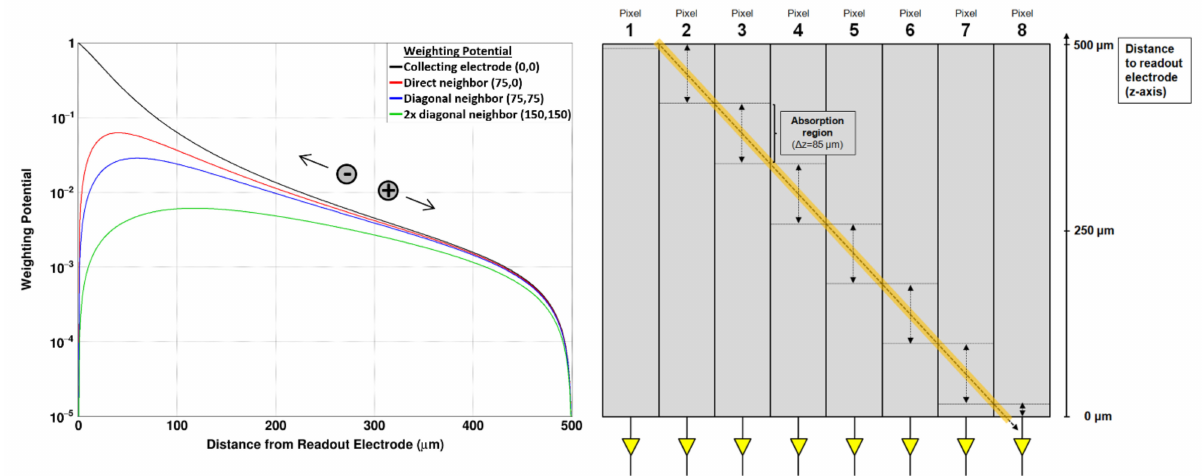
Figure 9. ( left ) Weighting potential calculated according to Riegler et al. at four different positions: above the readout electrode (0 µ m, 0 µ m), above a direct neighboring pixel (75 µ m, 0 µ m), above a diagonal neighbor (75 µ m, 75 µ m), above a diagonal neighbor at twice the distance (150 µ m, 150 µ m). ( right ) Schematics on the angle-on measurement with a 45 keV focused beam (beam diameter of 10 µ m). The penetration angle was 48.6 degrees (with respect to the sensor surface) and the focused beam has been aligned along a pixel row. Overall, eight pixels along a column responded and the photons have been absorbed at different sensor depths. Determined by the penetration angle, the maximum absorption length along the pixel depth ∆ z in a single pixel was 85 µ m.